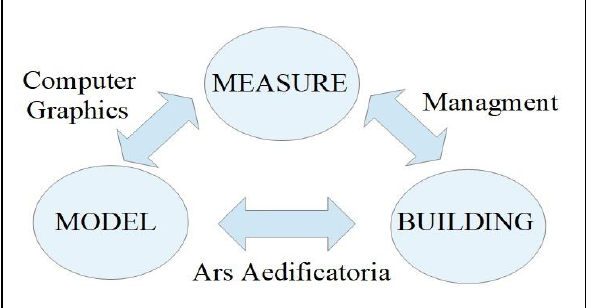
Figure 8 . Phases and knowledge: cyclical cognition